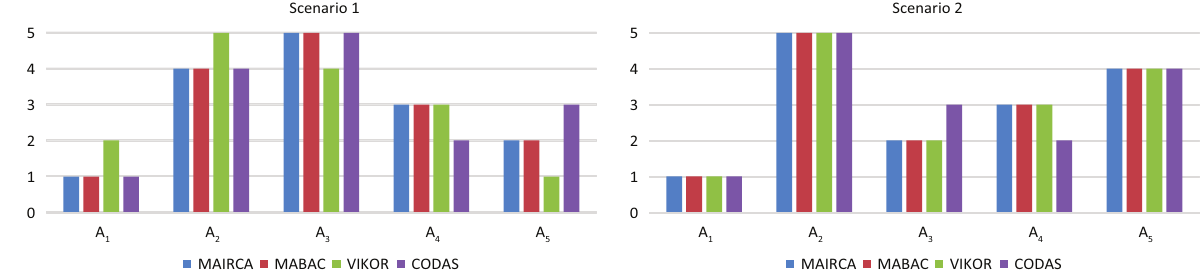
Figure 3. The ranking of the alternatives (Scenarios 1 and